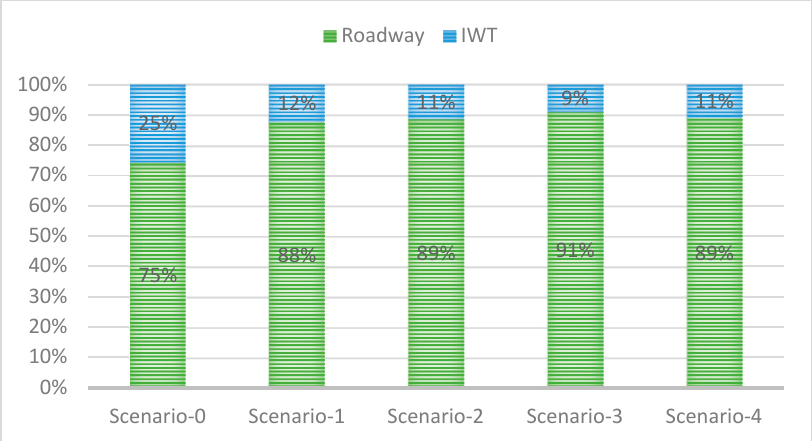
Figure 14. Proportion of transport modes from local collection hub to crossdocking center.